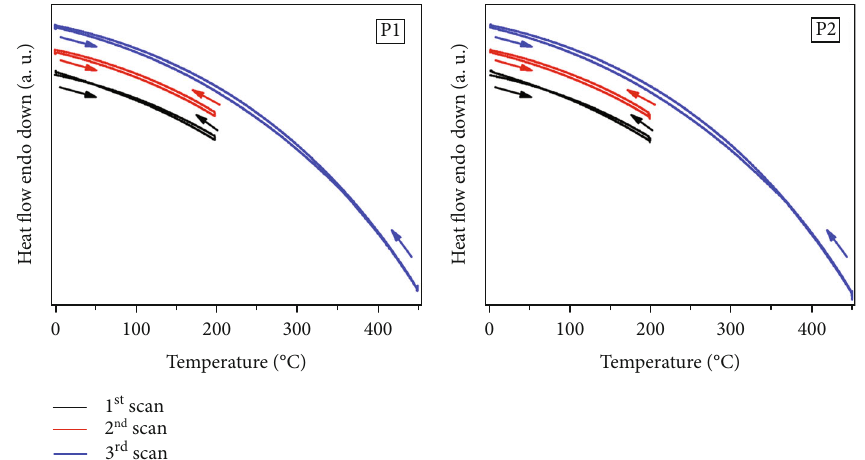
Figure 4: DSC thermograms of the polymers P1 and P2 with a heating and cooling rate of 10 ° C min − 1 . Note that the DSC thermograms of successive scans were o ff set for clarity.